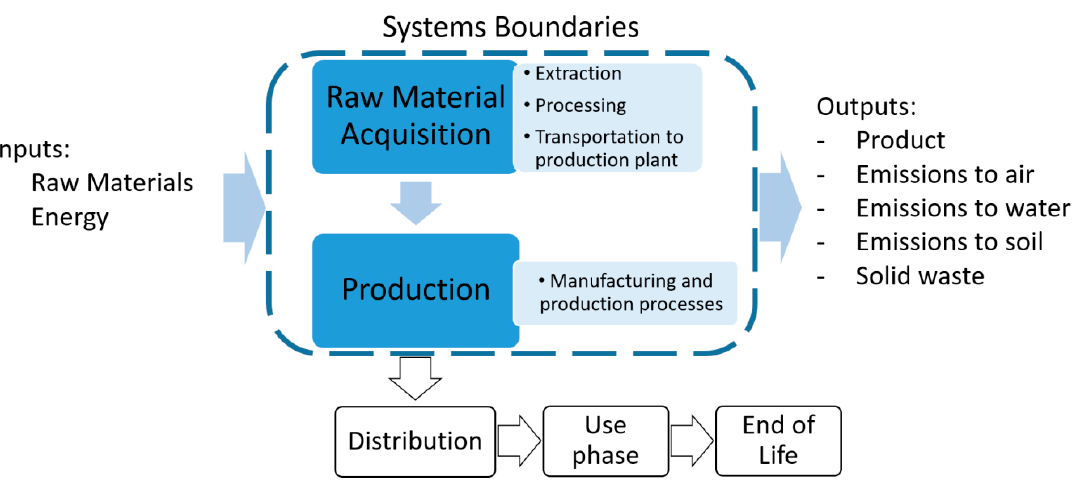
Figure 1. System boundaries.